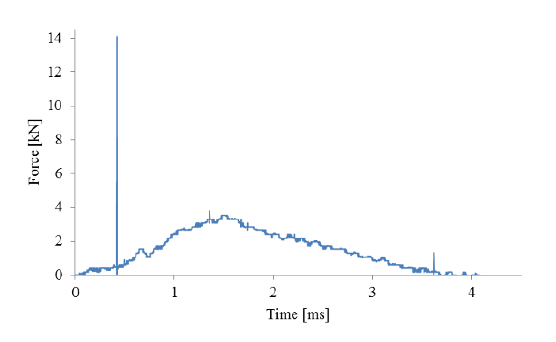
Figure 4. Recorded force-time curve at impact #7 with damage initi- ation stages.